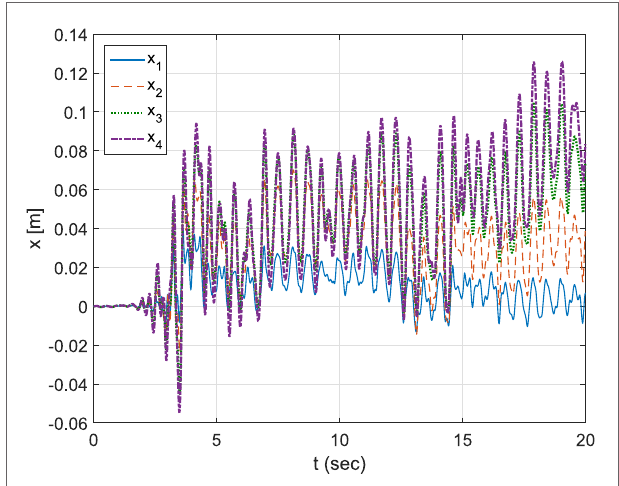
FIGURE 7 | Displacements of the four masses of the